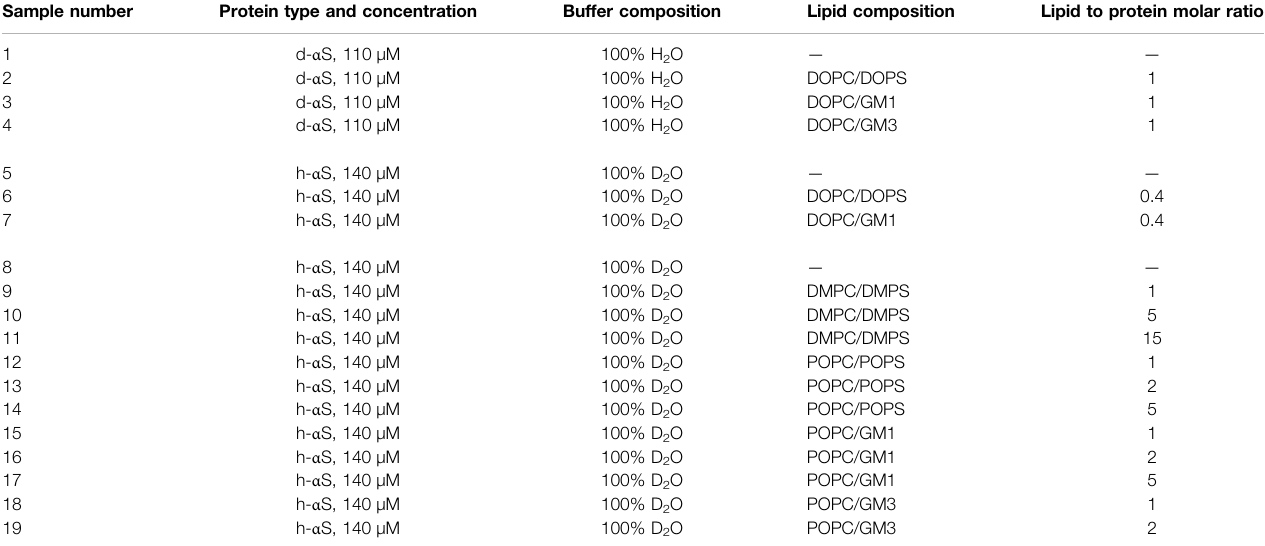
TABLE 1 | Summary of samples investigated. The table shows the protein and lipid concentration, lipid composition in model membranes and deuteration level of the buffer used in the scattering experiment (M (cid:1) mol/L). Sample number Protein type and